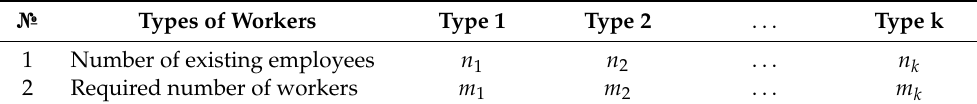
Table 2. Types of